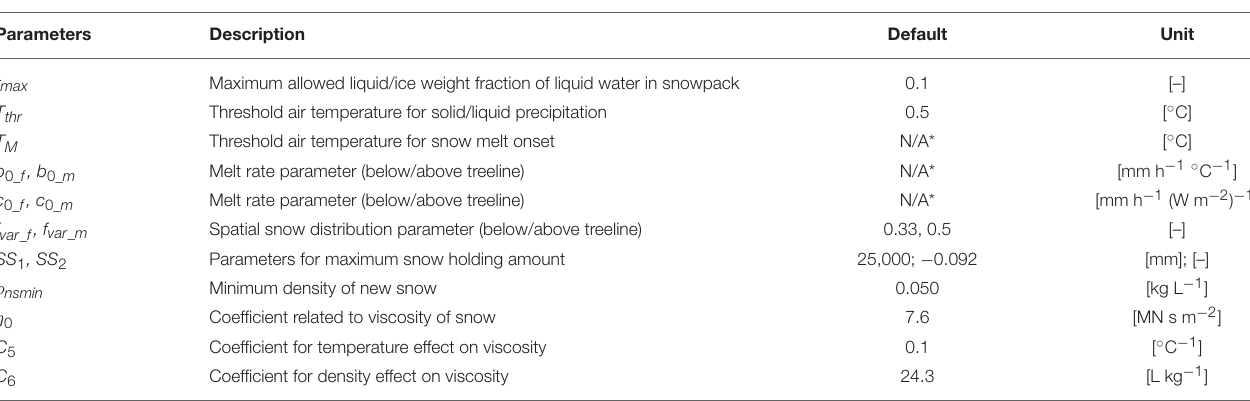
TABLE 1 | The main seNorge snow model parameters with their default